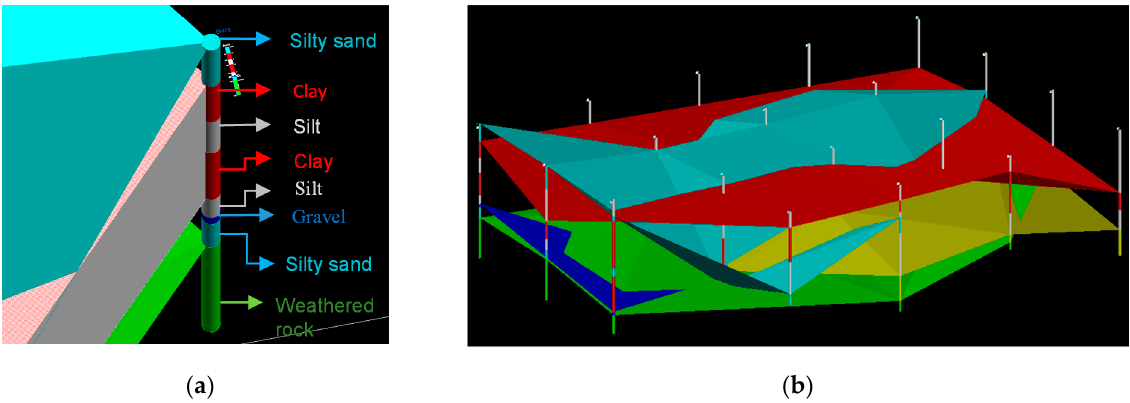
Figure 7. Visualization of geotechnical property models in BIM environment: ( a ) Three-dimensional borehole visualization showing geotechnical layers with different colors; ( b ) Interpolation of geotechnical property